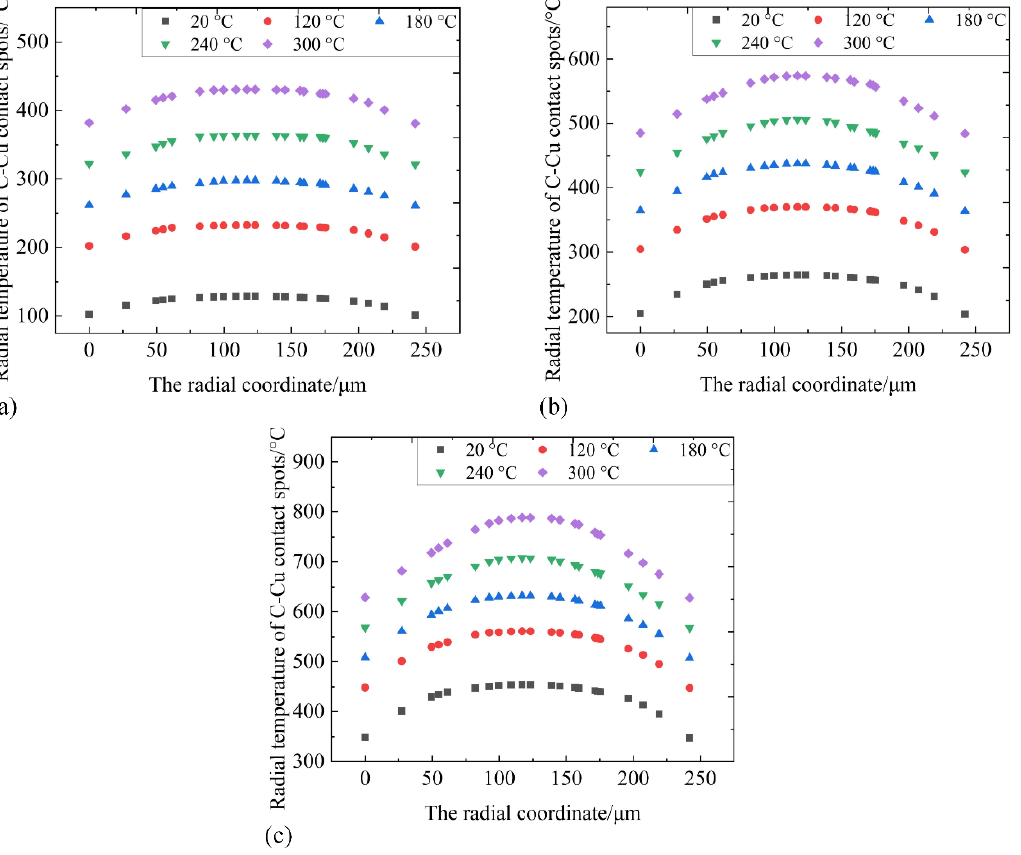
Figure 10. The radial temperature distribution on the surface of the C-Cu contact spots varies with interface temperature: ( a ) I = 40 A; ( b ) I = 60 A, and ( c ) I = 80 A.